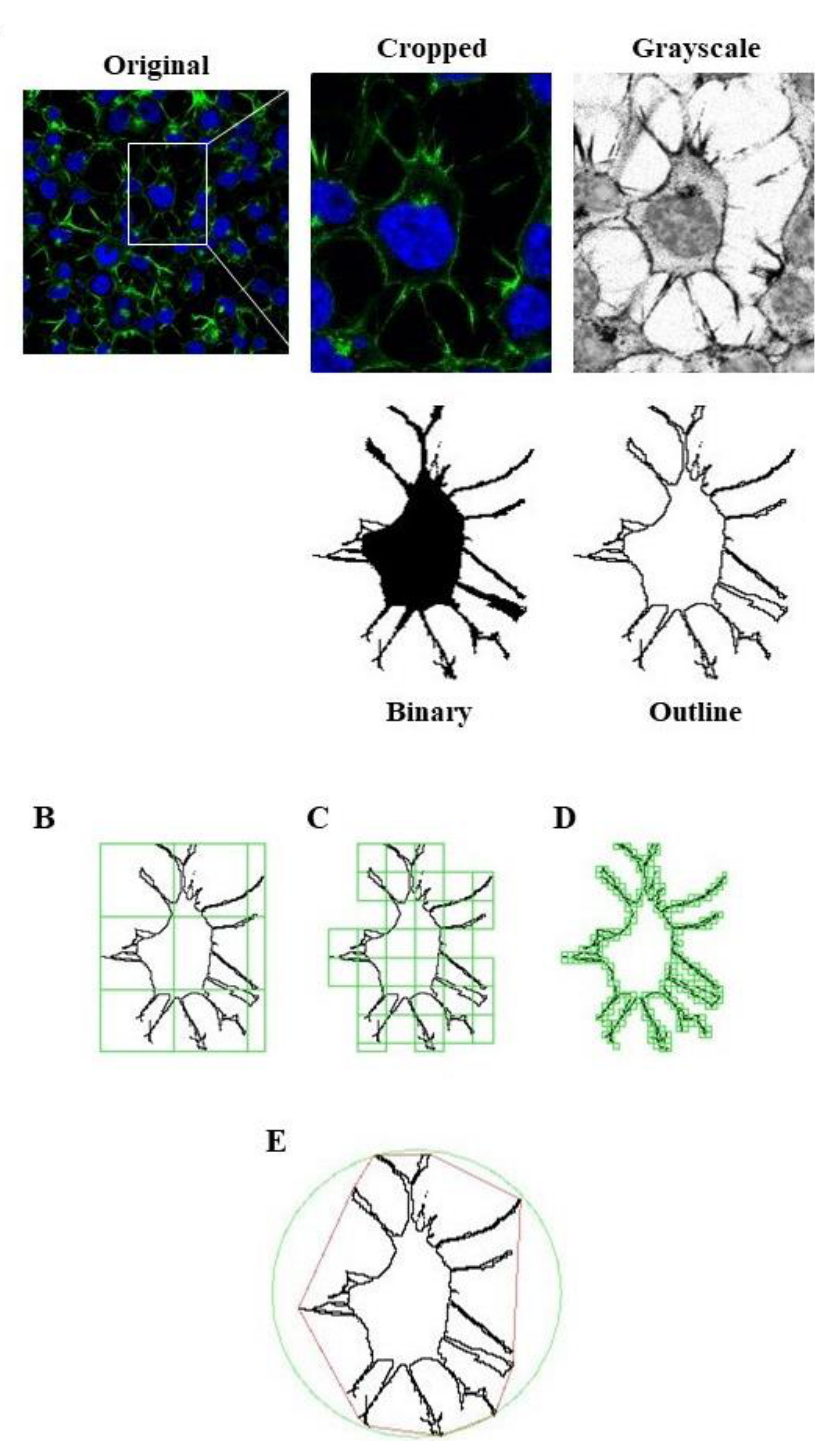
Figure 13. FracLac Analysis application to quantify Neuro-2A cells morphology. ( A ) Representative process applied to obtain an outlined single cell for FracLac plugin. After selecting a cell in the photomicrograph (63 × magnification), the image was cropped and modified to remove noise and enhance the background. The image was then processed to obtain an 8-bit grayscale microphotograph, and binarized. Binary image was manually edited to clear the background and to join all branches, and finally outlined. FracLac quantifies cell complexity and shape with a box counting method which permits to quantify fractal dimension ( B ), lacunarity ( C ), perimeter ( D ), and the maximum span across the convex hull ( E ) by drawing a convex hull (pink) and a bounding circle (green).